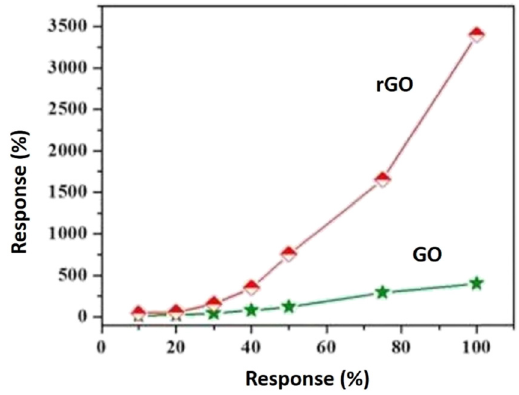
Figure 18: Comparative ammonia sensing response of GO and rGO fi lm. Adapted from ref. [ 124 ]